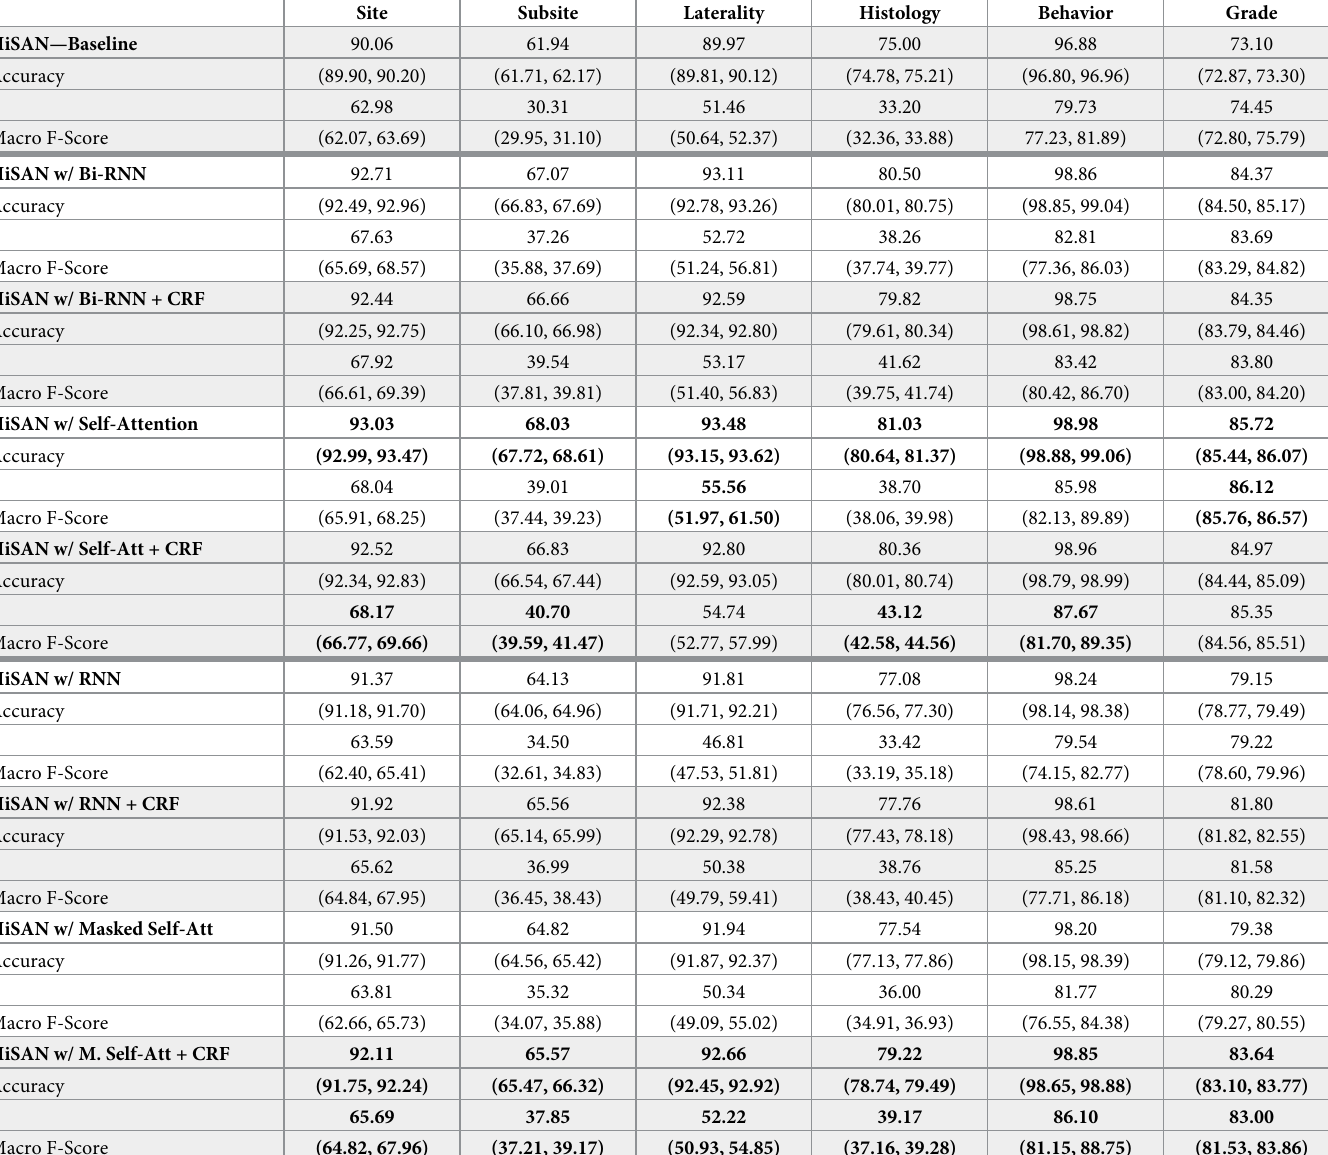
Table 2. Accuracy and macro F-Score (with 95% confidence intervals) of our different methods to capture case-level context on six different classification tasks using the HiSAN as the baseline. The top row is our baseline without any report level context, the middle group shows results of methods than can access both future and previous reports in a sequence, and the bottom group show results of methods that can only access previous reports in a